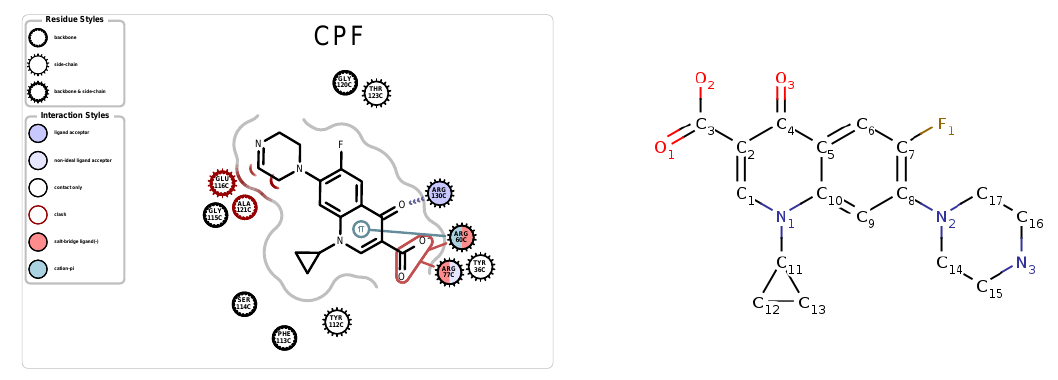
Figure 7. Protein-ligand map ( left ), and schematic ( right ) of Ciprofloxacin, CPF, from PDB